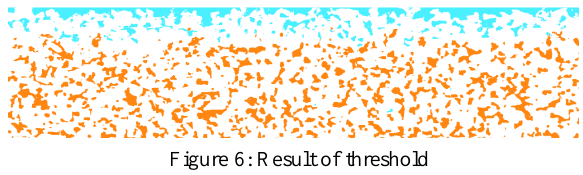
Figure 6: Result of